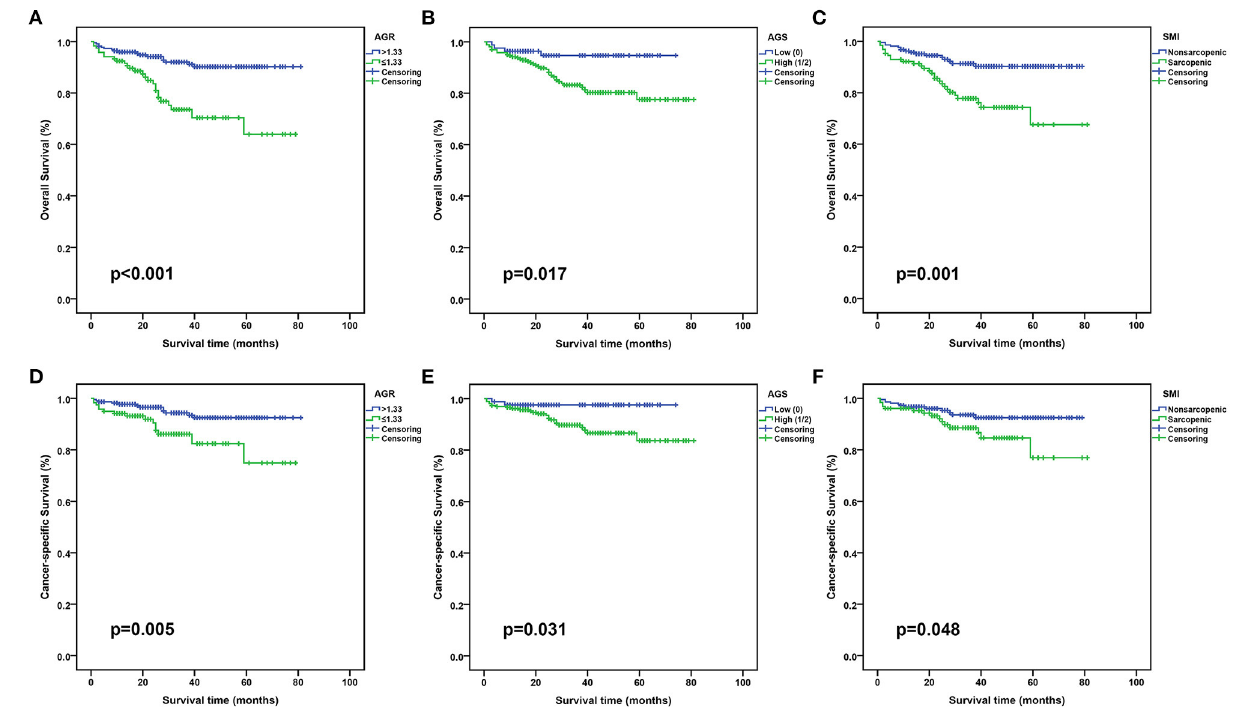
FIGURE 2 | Kaplan-Meier curves for OS and CSS stratified by AGR, AGS and SMI in the training set. (A,D) , AGR OS and CSS; (B,E) , AGS OS and CSS; (C,F) , SMI OS and CSS. OS, overall survival; CSS, cancer-specific survival; AGR, albumin to globulin ratio; AGS, albumin-globulin score; SMI, skeletal muscle